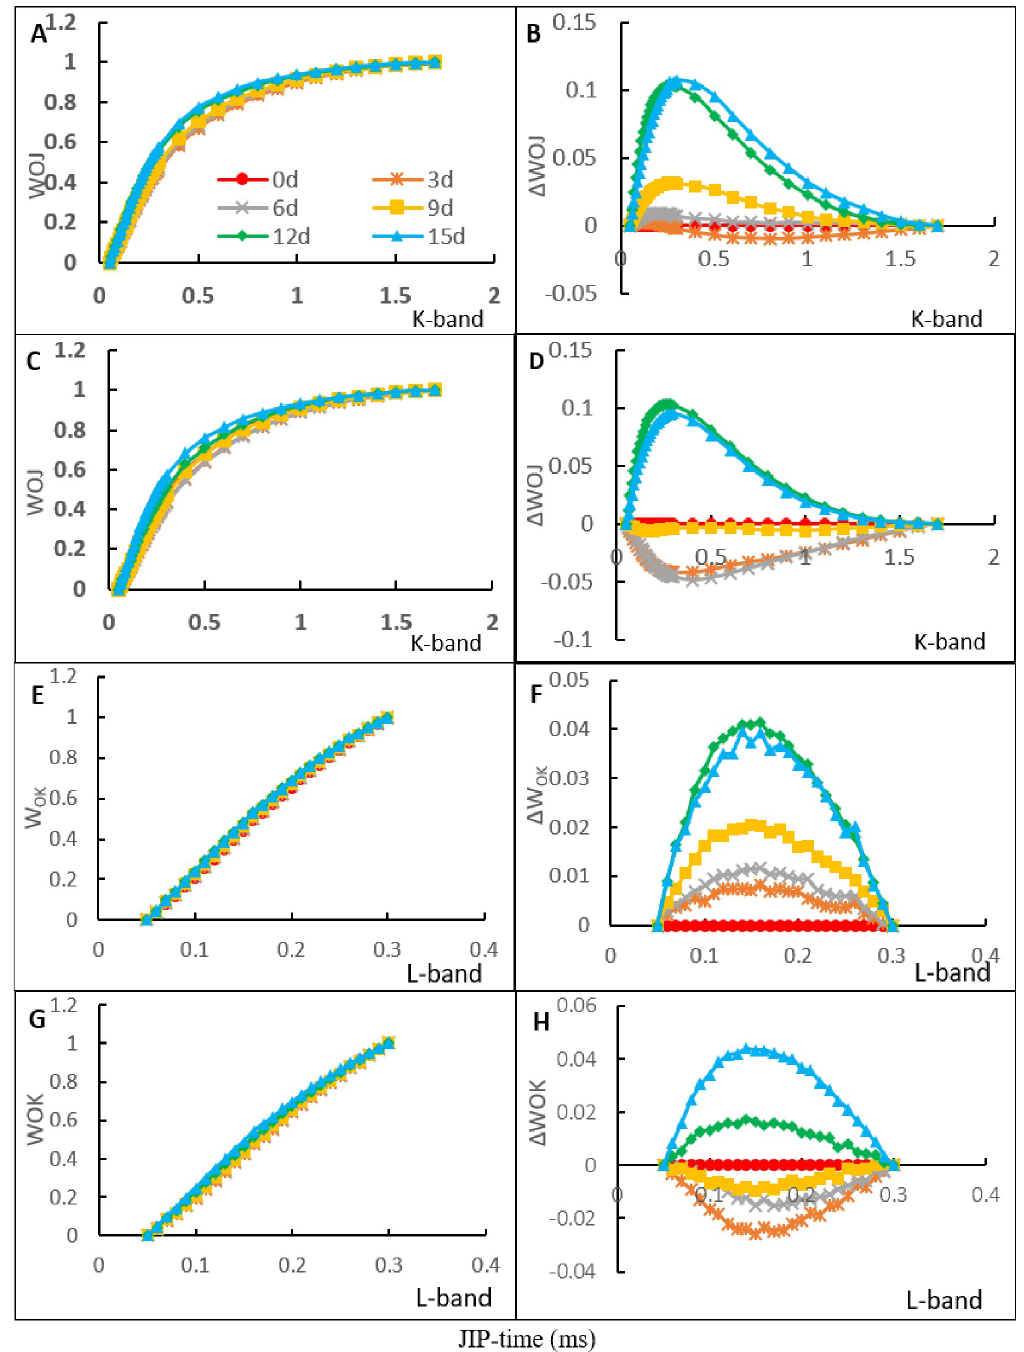
Fig 3. The curves of the K and L band in NaCl treatment and NaCl treatment with CaCl 2 amendment on the day of NaCl stress and on days 3, 6, 9, 12, and 15 of NaCl stress. (A, B, E, F) the curves of the K-band and L-band in NaCl treatment. (C, D, G, H) the curves of the K-band and L-band in NaCl treatment added CaCl 2 . The signals were plotted on a logarithmic time scale (JIP Time). Each value of the curves is the average of 3 replicates.